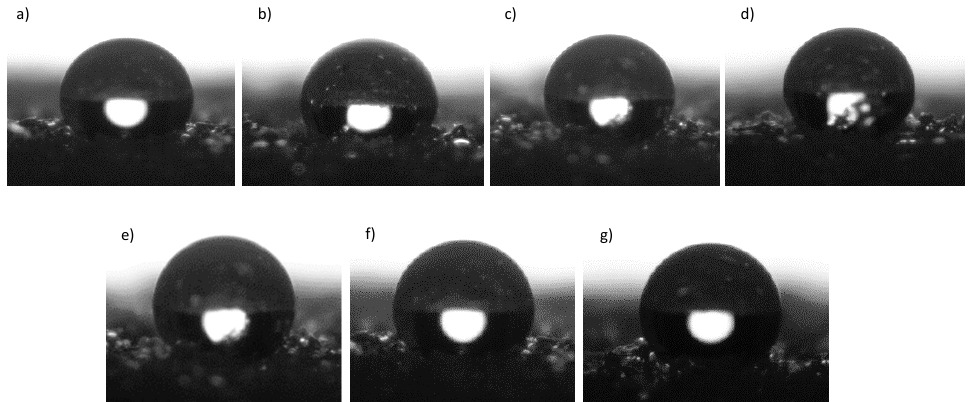
Figure 14. Contact angle of the surface of the ( a ) PU-0, ( b ) PU-APIB-0.5, ( c ) PU-APIB-1.5, ( d ) PU-APIB-5, ( e ) PU-AEAPIB-0.5, ( f ) PU-AEAPIB-1.5, and ( g ) PU-AEAPIB-5.